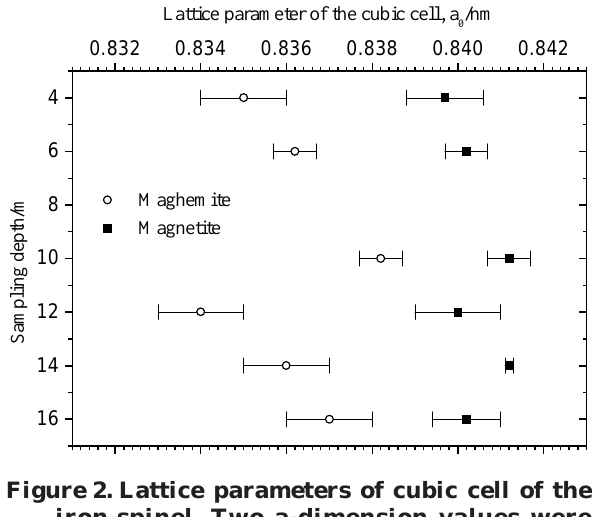
Figure 2. Lattice parameters of cubic cell of the iron-spinel. Two a-dimension values were determined in each sample, based on the split reflections of the powder X-ray